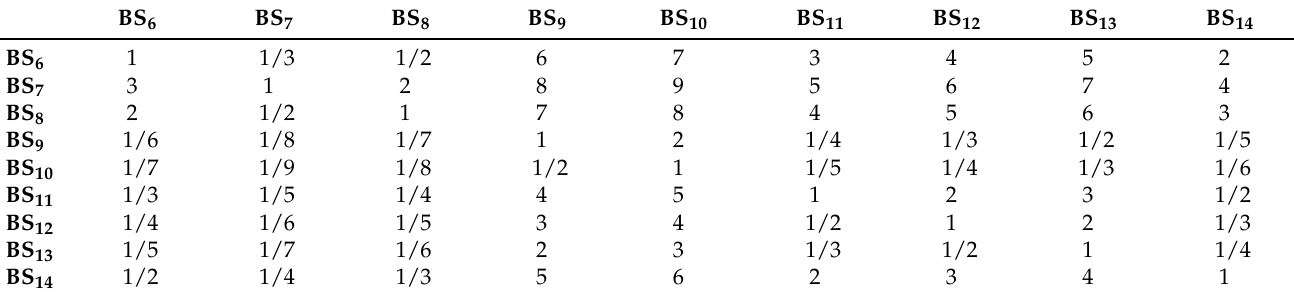
Table A13. The pairwise comparison matrix Admin _ C 1 .